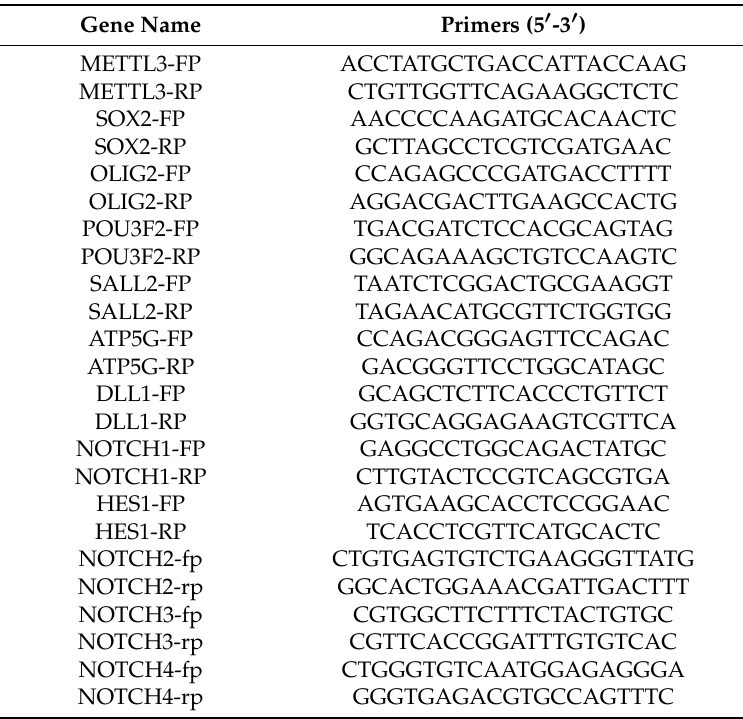
Table 1. List of the real-time primers